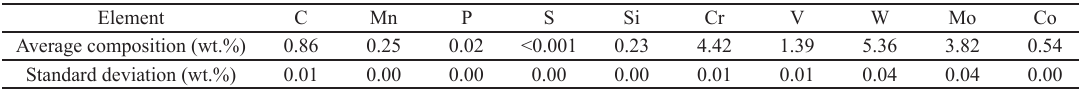
Table 1. AISI M35 chemical